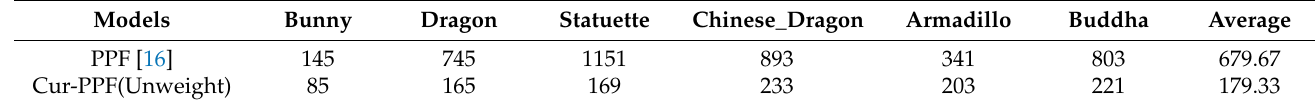
Table 2. Time using of PPF and Cur-PPF(Unweight) algorithms on public data set (ms/scene).